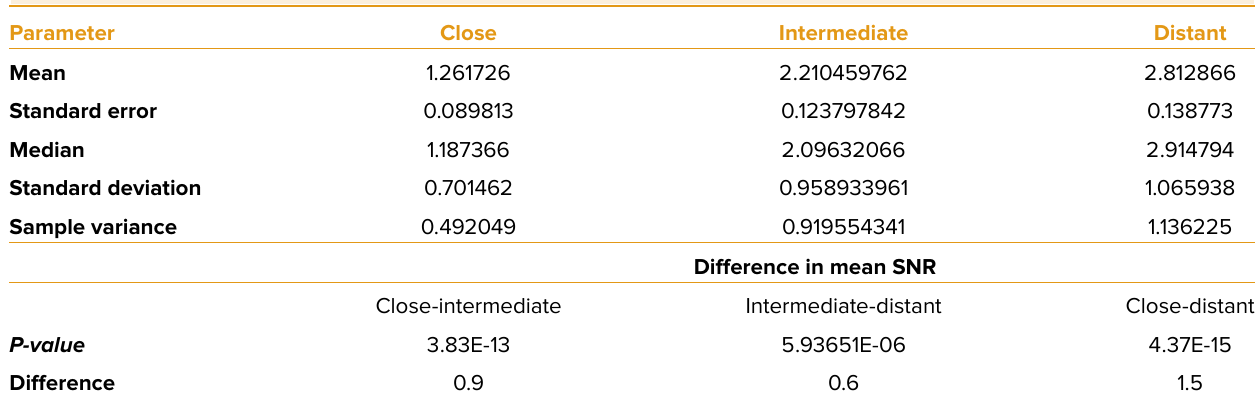
Table 4. SNR analysis summary for different lighting scenarios, namely Close, Intermediate, and